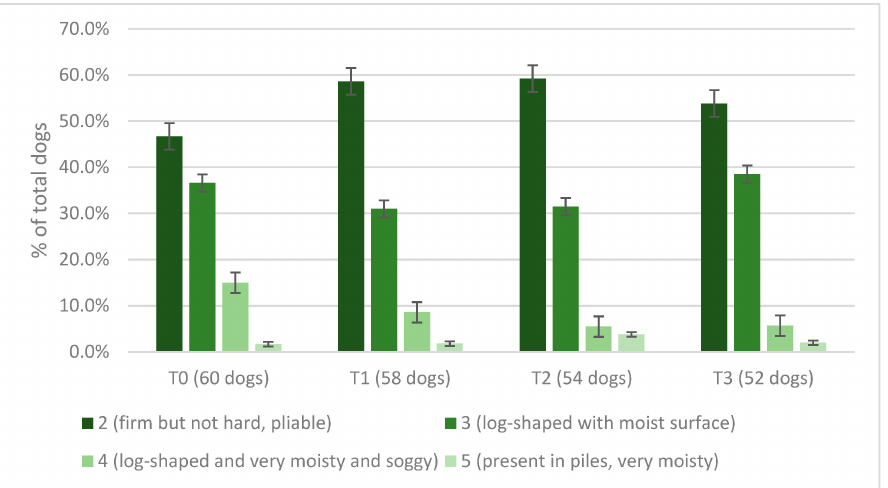
Figure 2. Fecal score of dogs according to owners at T0, T1, T2, and T3 (no owner reported a fecal score equal to 1, 6, or